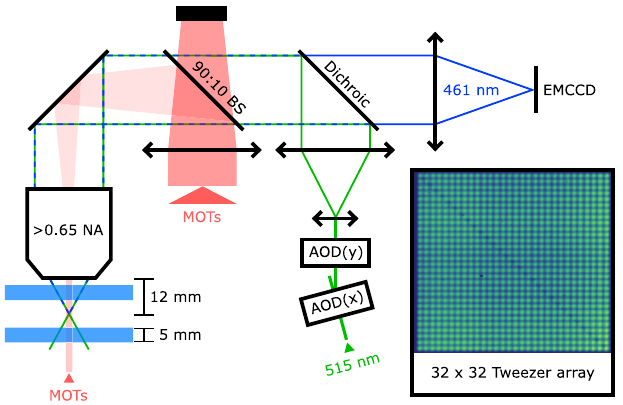
FIG. 5. Simplified schematic of optics layout. The vertical MOT beams (at both 689 and 461 nm) are combined onto the beam path with a custom 90 ∶ 10 beam splitter (BS). The 515-nm tweezer light is combined onto the imaging beam path with a dichroic mirror designed to be maximally transmissive at 461 nm and reflective at 515 nm. The waist of the beam entering the objective is 12.6 mm. Inset: Example of 32 × 32 tweezer array (with no atoms) imaged onto a